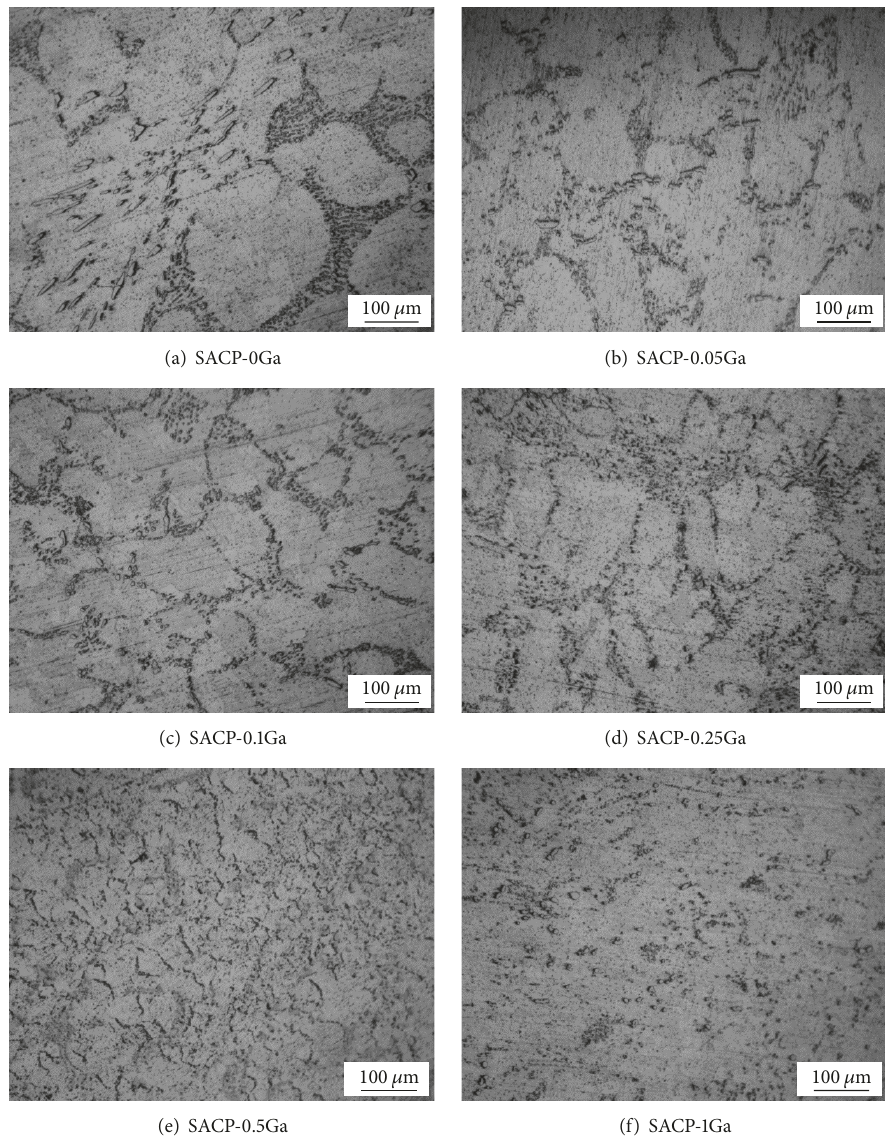
Figure 2: The microstructure of SACP0507- 𝑥 Ga